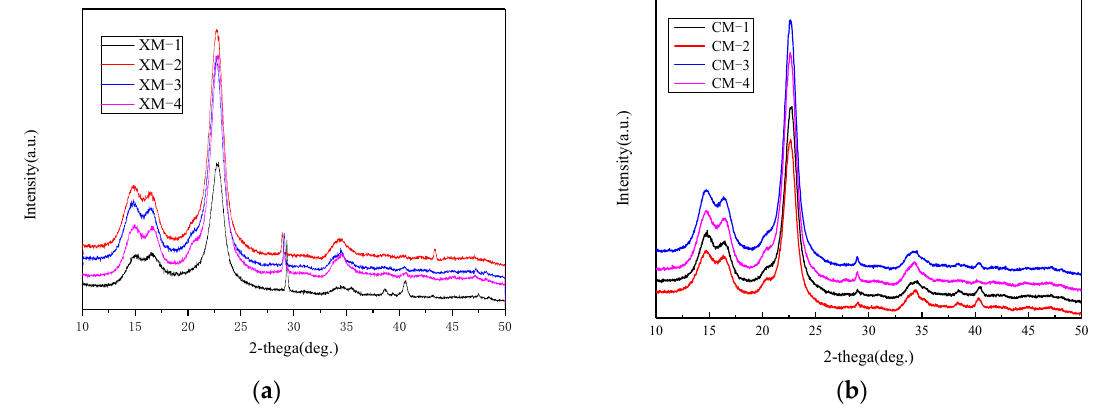
Figure 6. X-ray diffraction patterns of fibers harvested from ( a ) XM and ( b ) CM.